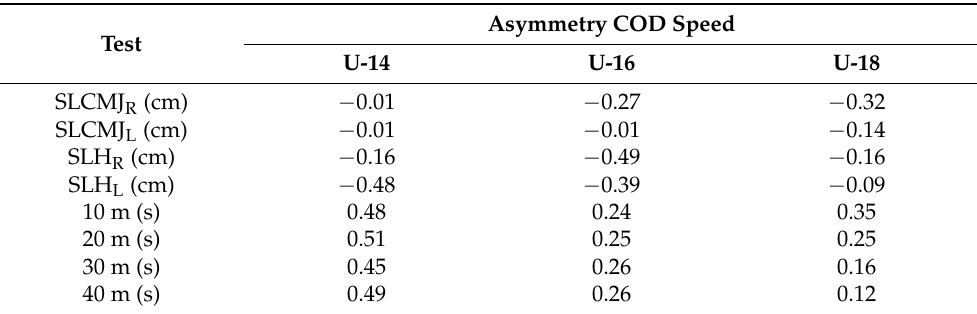
Table 5. Spearman’s ρ correlation between change of direction (COD) speed asymmetry and test across age groups.